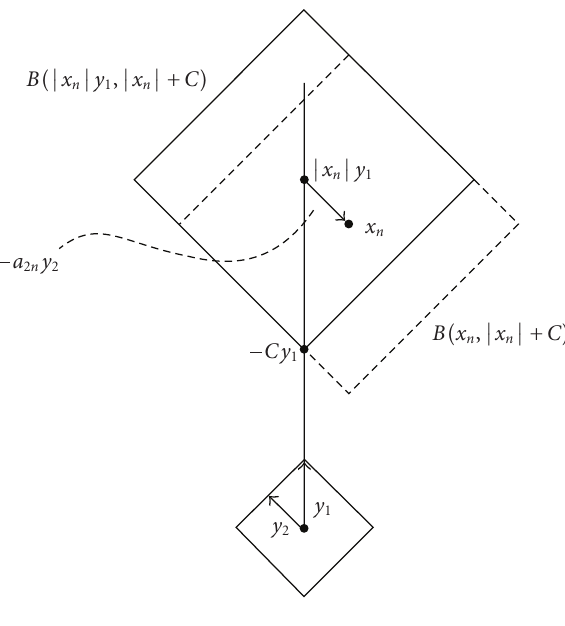
Figure 4.1. The decomposition of x n